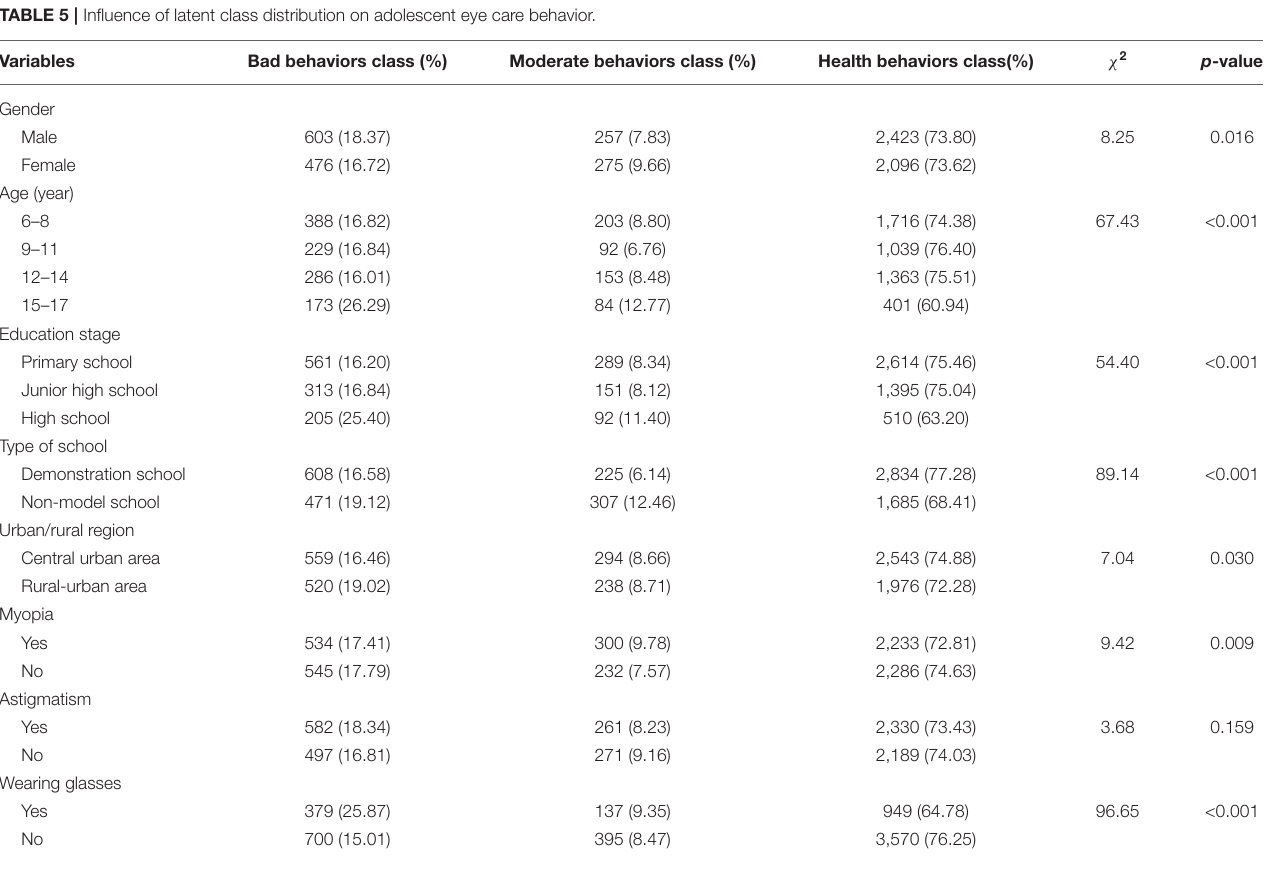
TABLE 5 | Influence of latent class distribution on adolescent eye care